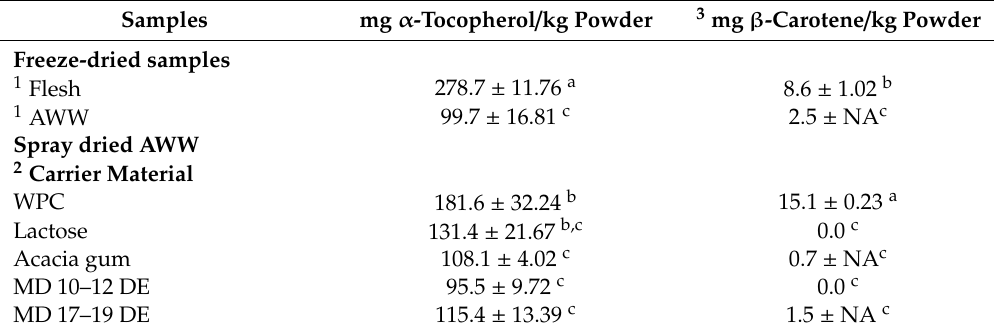
Table 2. Total α -tocopherol and β -carotene content of freeze-dried and spray dried AWW and avocado flesh.